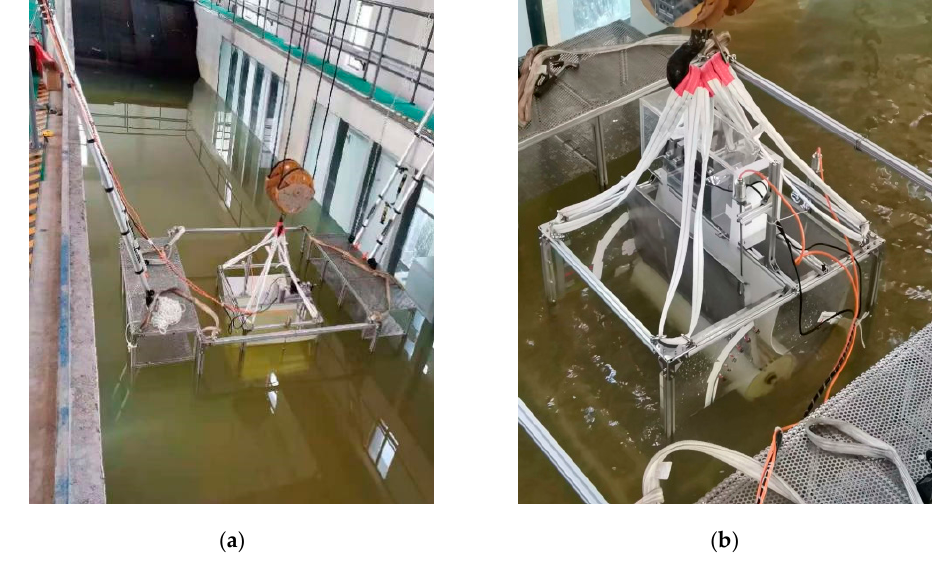
Figure 8. Water tank experimental setup of model prototype: ( a ) Hoisting; ( b ) Model experiment.